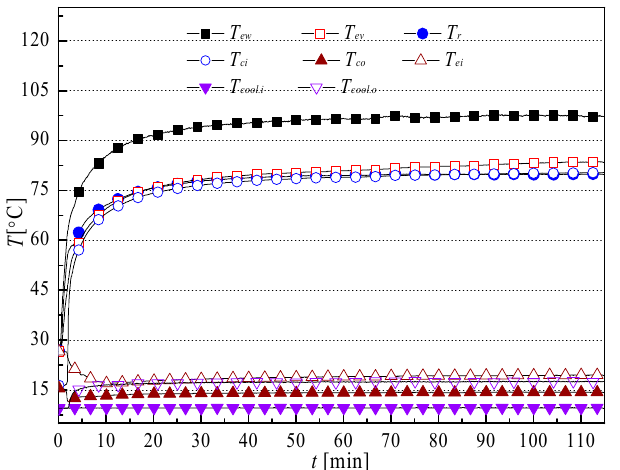
Figure 8. Start-up at evaporator thermal load of 120 W with horizontal alignment.